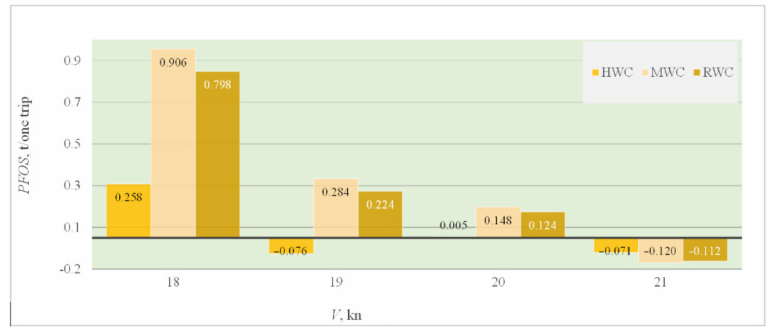
Figure 24. PFOS per one trip for navigation under MWC, HWC, and RWC.